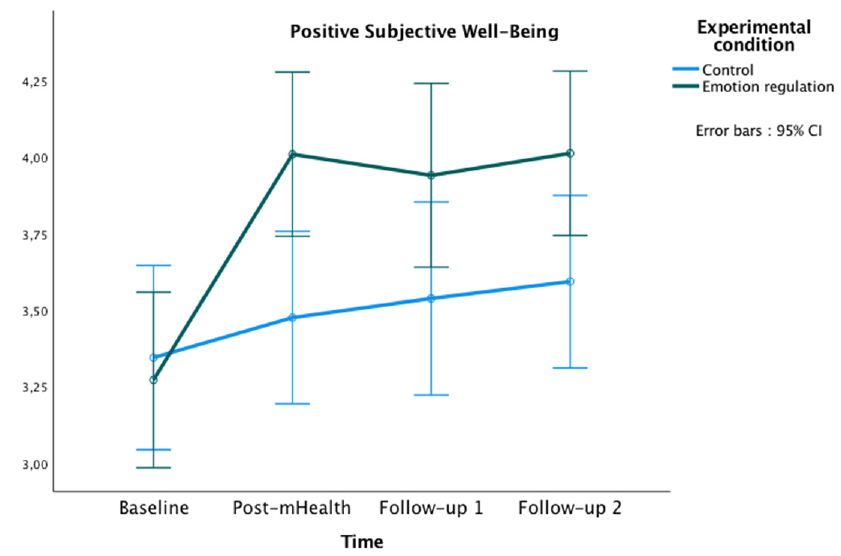
Figure 2. Changes in Positive Subjective Well-being in both groups over